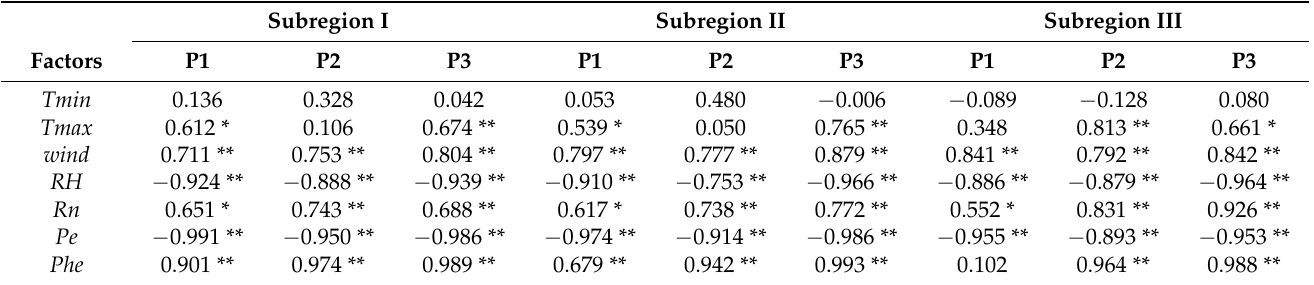
Table 2. Partial correlation coefficients and significance of interannual variation between IR and various factors in P1, P2 and P3 stages of winter